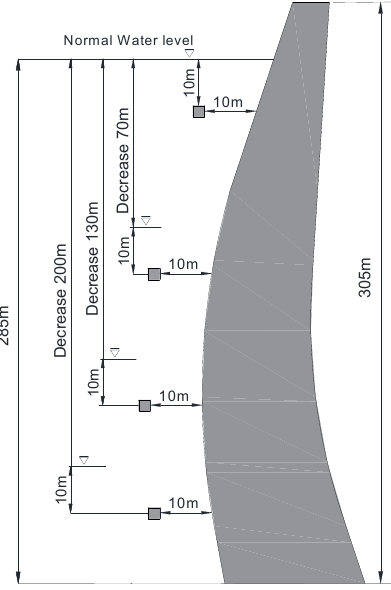
37 of 51 Figure 21. Dam crest monitoring points’ dynamic response at various horizontal detonation positions. 3.4.4. The Effect of the Reservoir’s Water Level on the Anti-Explosion Performance of Concrete Arch Dams There are indications of modern warfare, and major water conservancy infrastruc- tures, as the first key targets of general warfare, can implement civil air defense measures for early warning and water release. The influence of the reservoir water level in front of the dam on the anti-explosion performance of the dam after early warning water release is studied using the non-overflow section of a concrete arch dam as the research object. Different water levels in front of the dam have a strong influence on the dam body’s fail- ure. So, the dam body’s dynamic response and the damage caused by the explosion are computed. This section establishes the finite element full coupling model when the water level in front of the dam is the normal water level, the water level drops by 70, 130, and